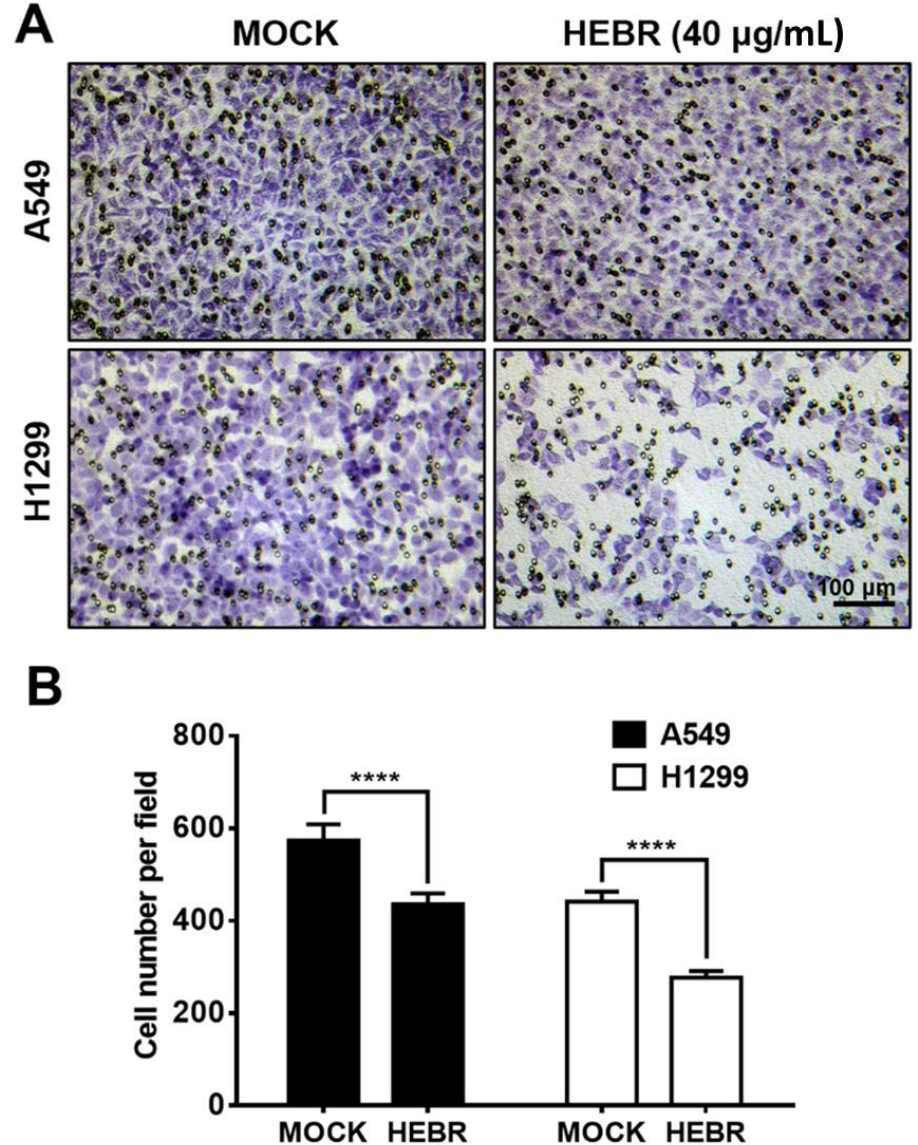
Figure 4. Inhibition of cell invasion by HEBR protein. ( A ) Transwell assay for the ability of A549 and H1299 invasion was conducted after treatment with HEBR (40 µ g/mL) for 24 h. The number of A549 and H1299 cells invading through the transwell membrane significantly decreased upon the HEBR treatment. ( B ) The cell invasion ability was evaluated by counting cells per field using GraphPad Prism 5 software. Data are presented as means ± SD (n = 3~4). Asterisks indicate statistically significant differences, **** p ≤ 0.0001.